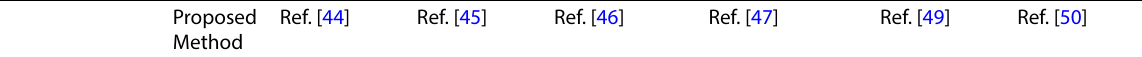
Table 5 Comparison of proposed method with existing pseudo-random number generation techniques on basis of Chaos Properties, Secu- rity Analysis and Statistical